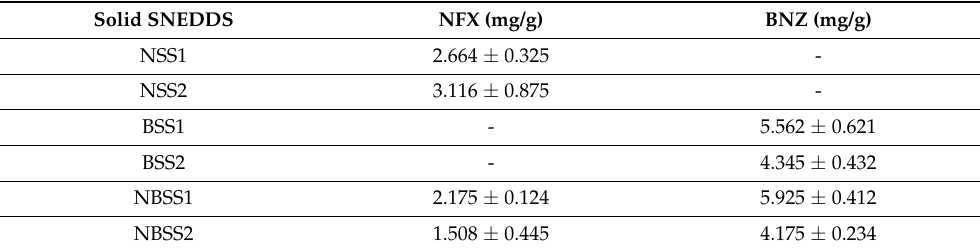
Table 4. Solid SNEDDS drug